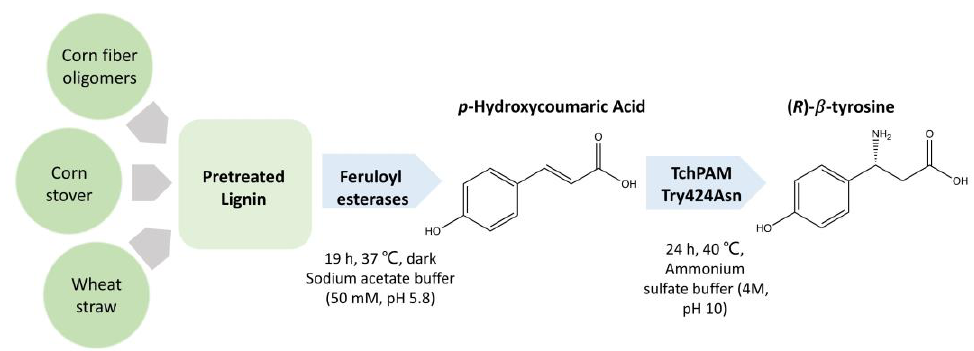
Figure 6. Proposed pathway for multi-enzymatic synthesis of ( R )- β -tyrosine with high enantiopurity starting from the pretreated lignin.